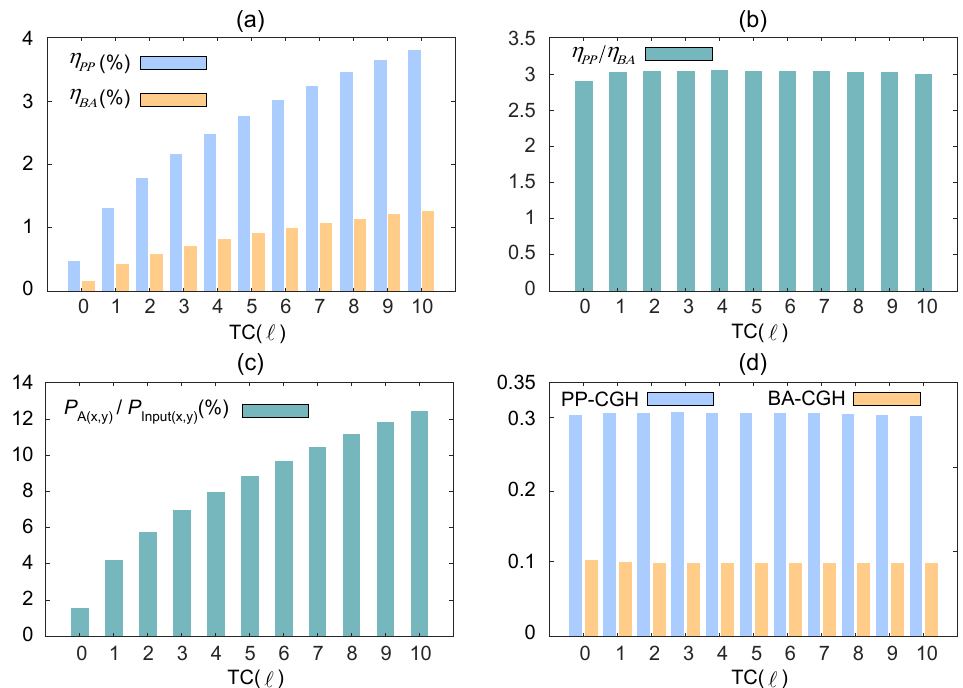
Figure 6. Tailored efficiency of holographic generation for vortex beams. ( a ) Bar chart of tailoring efficiency for PP-CGH and BA-CGH methods, ( b ) ratio of tailoring efficiencies of two methods, ( c ) the ratio of target light field energy to energy within the computational aperture and ( d ) extraction efficiency of target light field for PP-CGH and BA-CGH